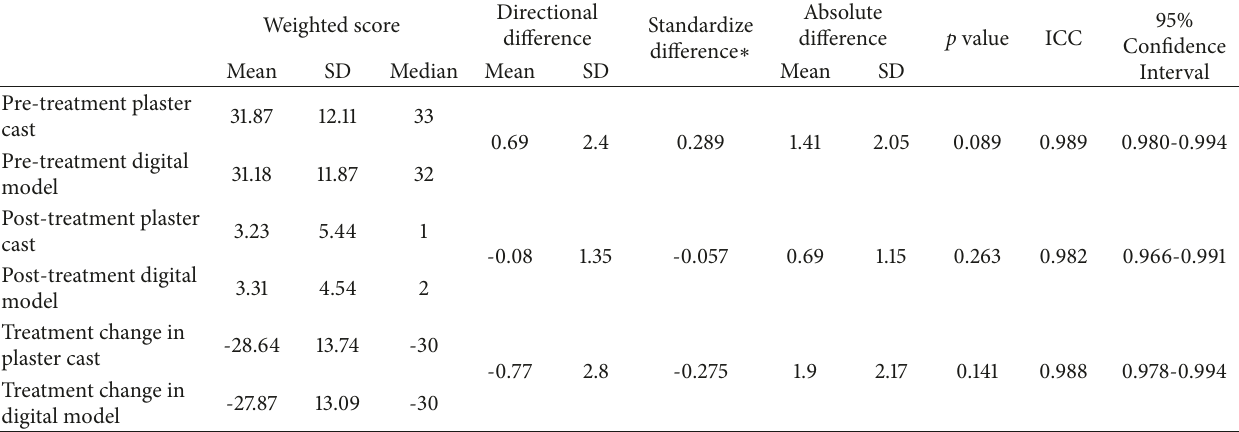
Table 1: Agreement between digital models and plaster casts in assessment of PAR. Weighted score